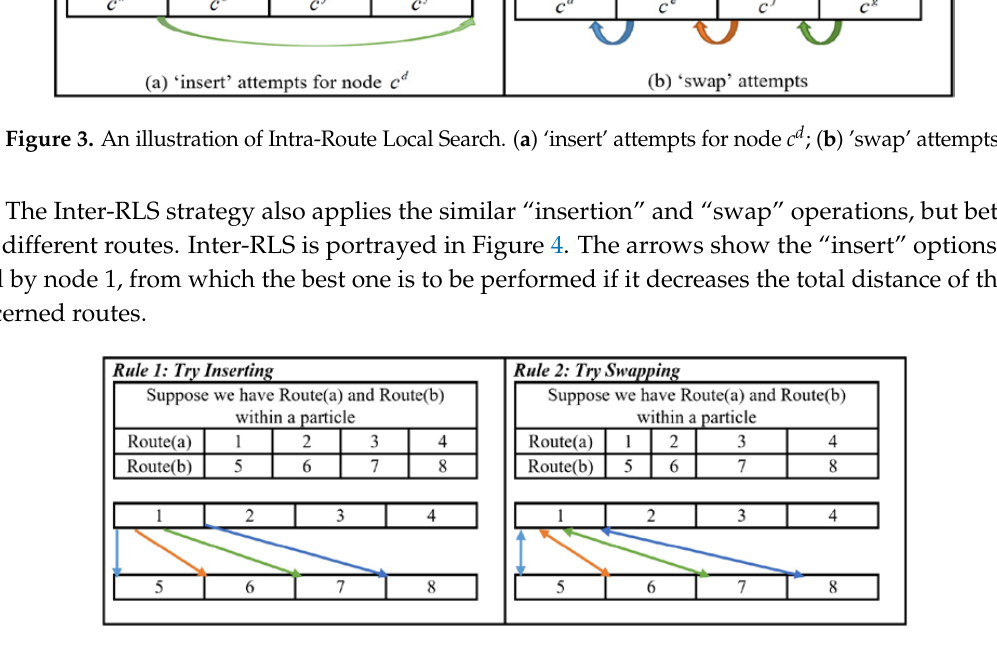
Figure 4. An illustration of Inter-Route Local Search.